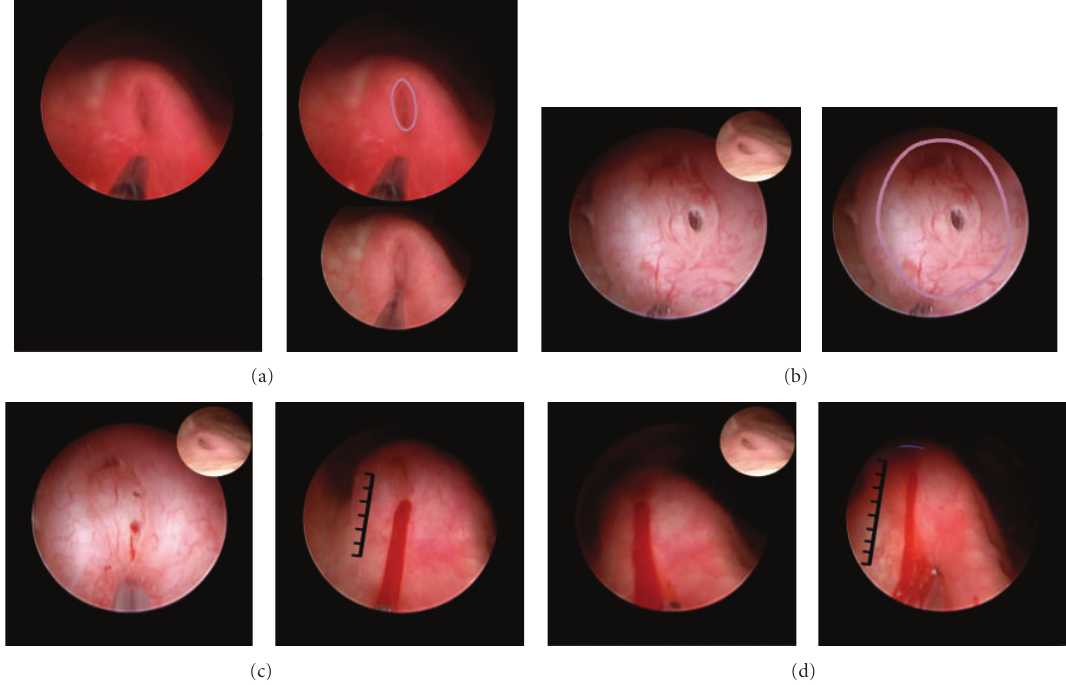
Figure 5: Procedure as CEVL components in a case of grade IV reflux in an infant girl. (a) Ureter orifice injection sequence. Inner margin of orifice (top left). Needle tip targets the injection site into the inner margin of ureter orifice (top right overlay). Bottom right: needle tip has penetrated inner margin of ureter orifice. (b) Injection at inner margin of orifice is now complete as the orifice is raised further above bladder surface. Hole in mucosa represents previous needle penetration. This component is complete as this appearance shows that the implant mound obscures view of the ureter lumen and has further elevated the ureter orifice. (c) Outer margin of ureter orifice sequence. Left: needle tip targets next injection at the outside margin of orifice. Right: after injection there is additional bulking of the orifice which is further elevated (graduated rule). There is an insignificant blood stream from the site of previous injection. This component is complete as the implant injection further elevates the ureter orifice. (d) Base of ureter orifice injection sequence. (a) Needle tip targets injection site at base of mesa. (b) After injection. This component is now complete as the mesa is further elevated (graduated rule), ureteral meatus is slit-like (blue crescent), and the meatus does not show hydrodistention (not shown). This appearance is compared with the icon representing the orifice before